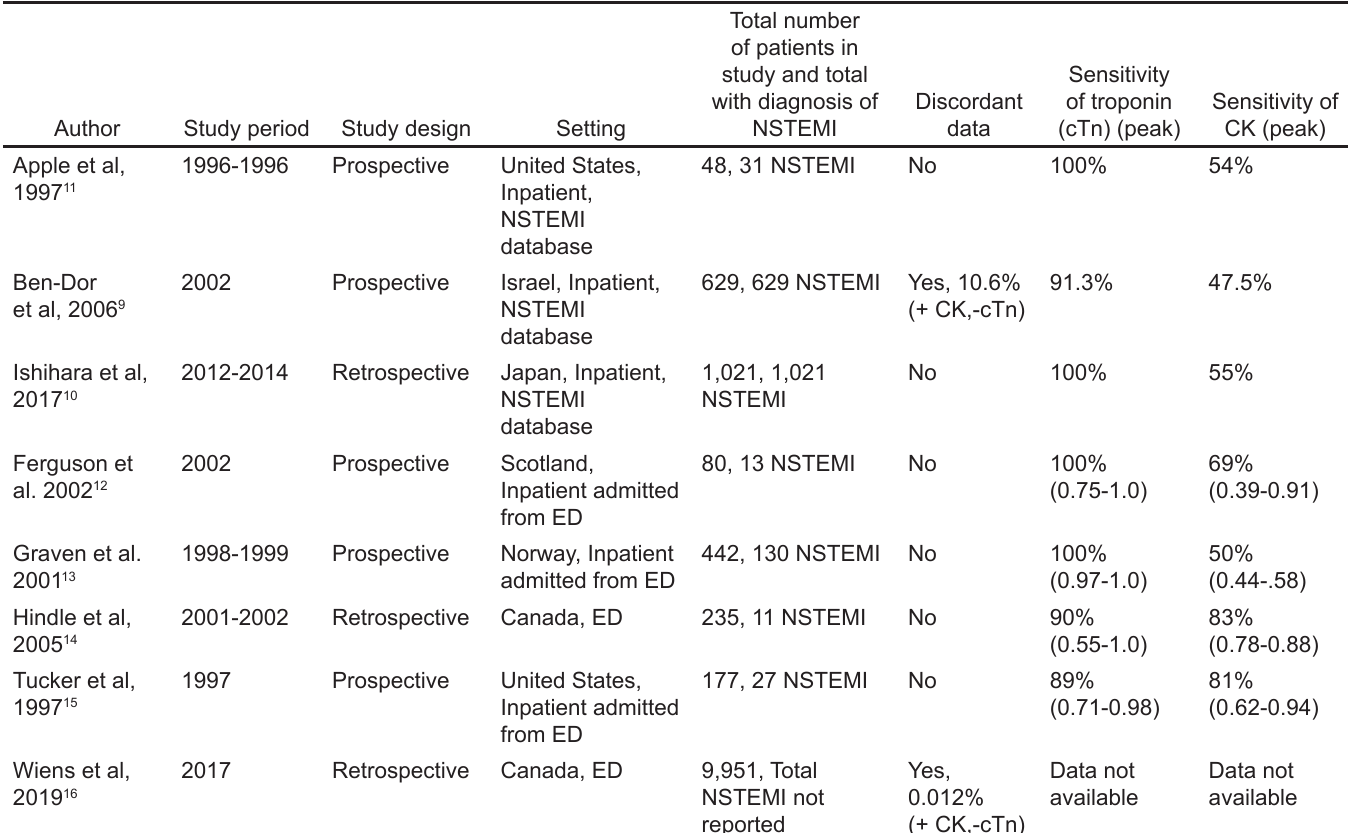
Table 1. Characteristics of included